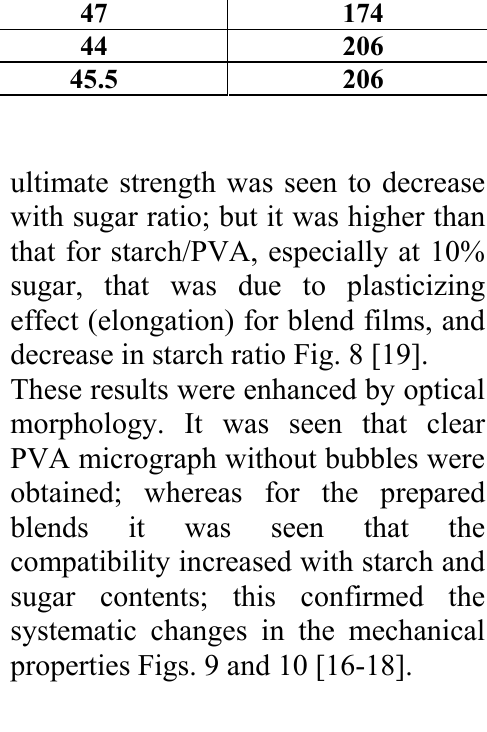
, T for the prepared g m